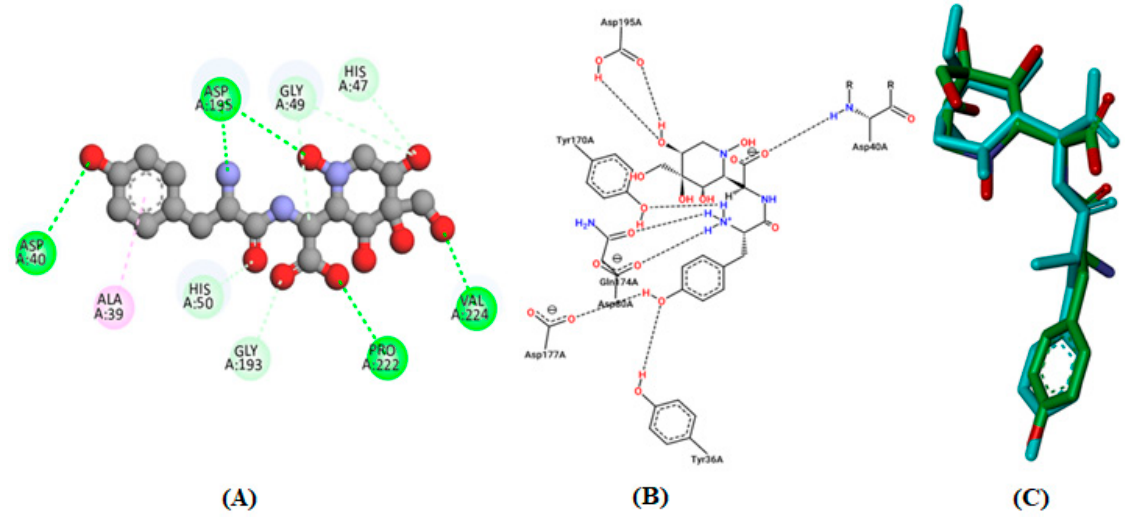
Figure 3. The results of intermolecular interaction between 1JIJ.pdb protein and co-crystallized ligand, which are produced computationally ( A ) and experimentally ( B ), and the result of superposition pose with RMSD of 1.375 Å ( C ).